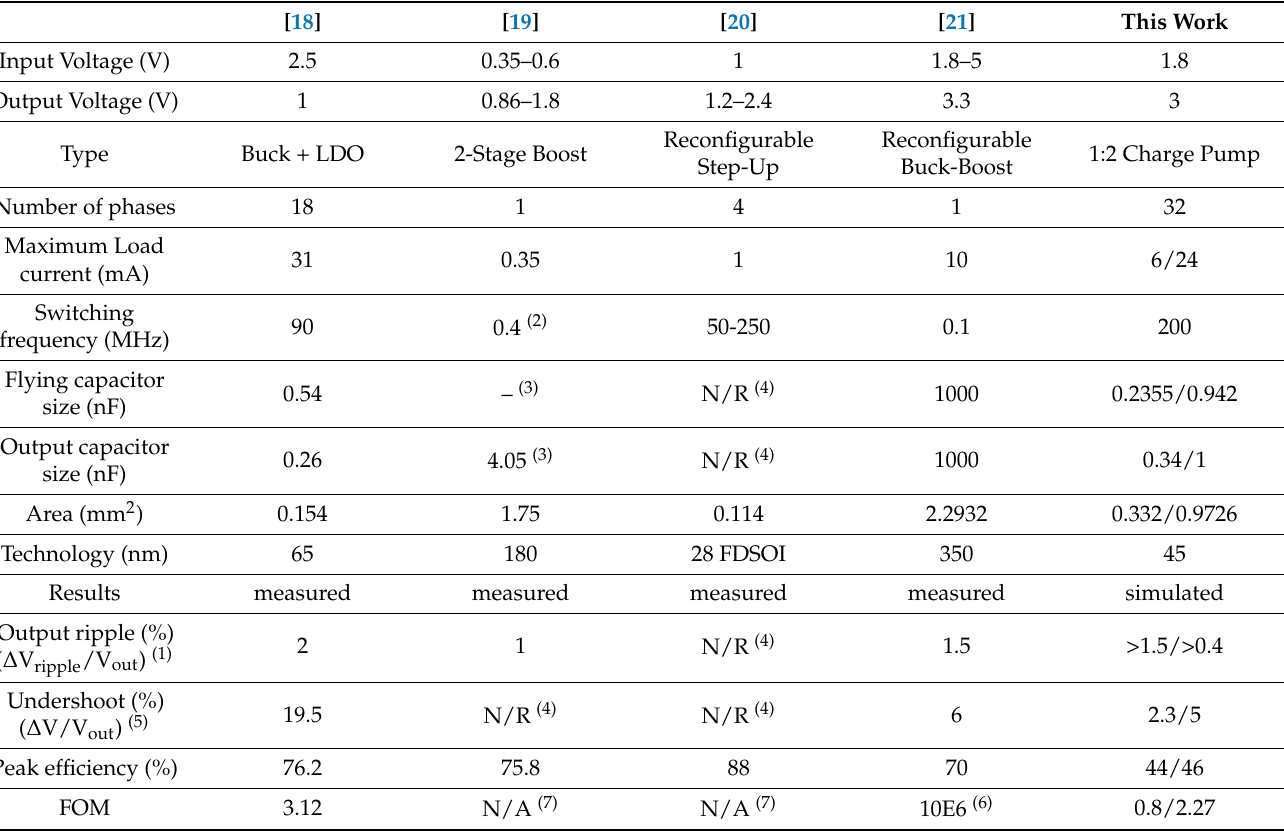
Table 2. Comparison between the proposed converter and other boost converters found in the